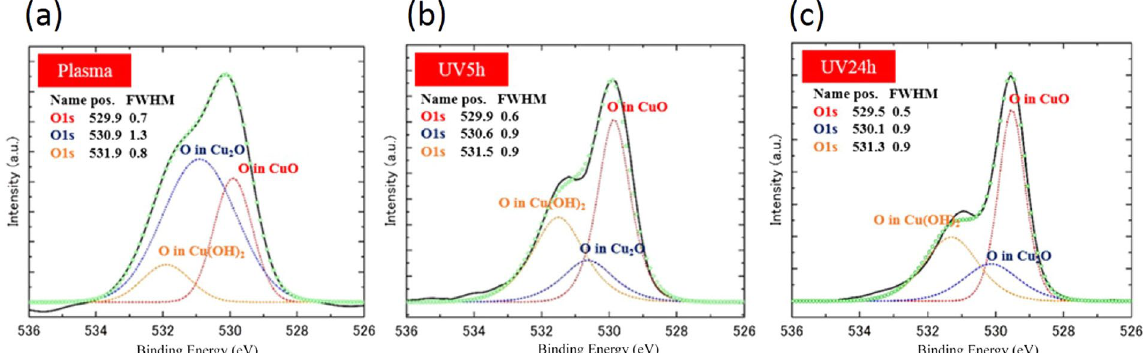
Figure 4. XPS spectra. XPS data of the sample after plasma treatment and after UV irradiation. ( a ) Plasma treatment, ( b ) UV 5 hours, ( c ) UV 24 hours.